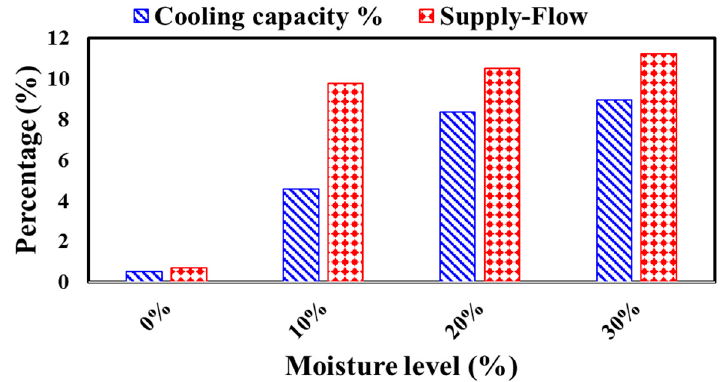
Figure 7. Yearly additional cooling capacity and supplied air flow (in percentages) by employing variable thermal conductivity as compared with constant values at different moisture levels in the hot climate of UAE.